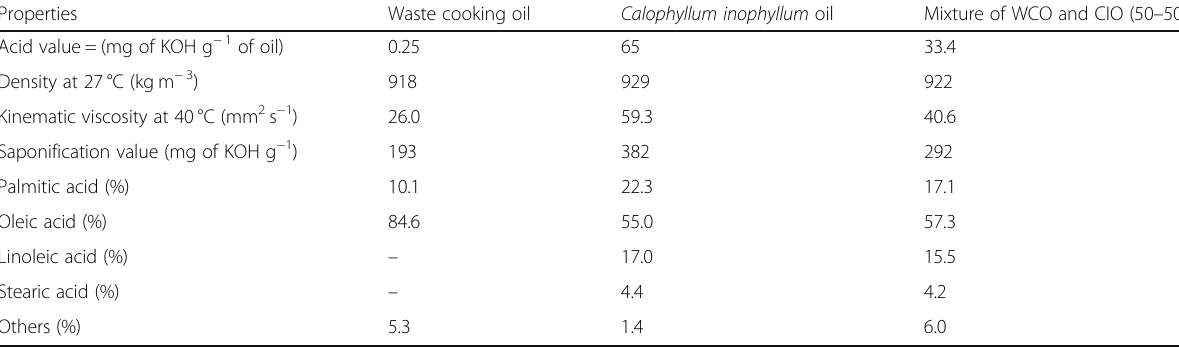
Table 2 Physicochemical properties and fatty acid composition of CIO and WCO